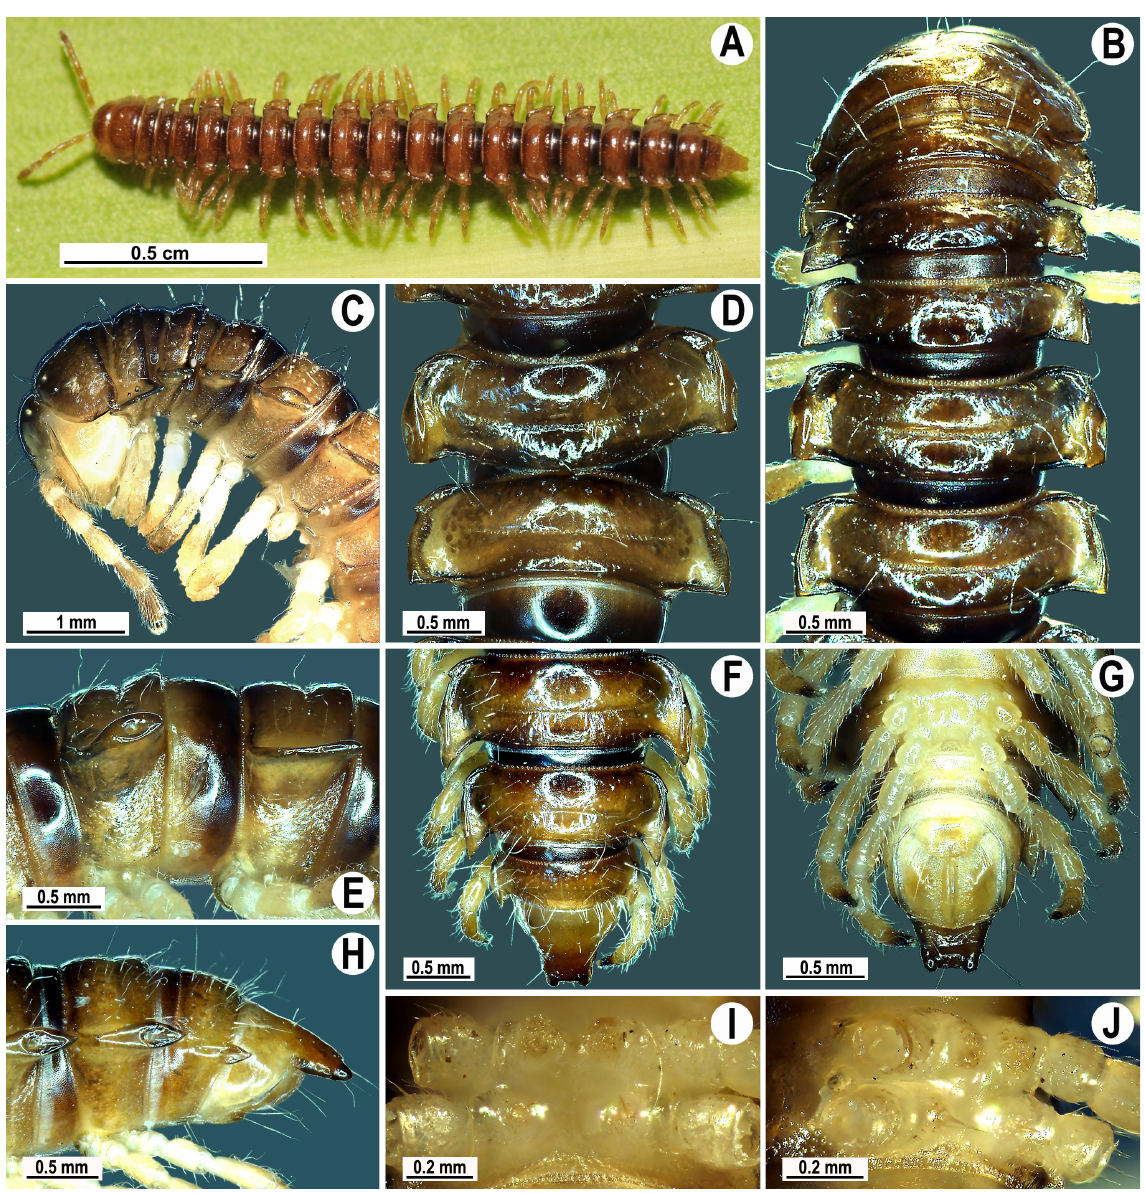
Fig. 10. Tylopus retusus sp. nov., holotype, ♂. A . habitus, live coloration. B–C . anterior part of body, dorsal and lateral views, respectively. D–E . Segments 10 and 11, dorsal and lateral views, respectively. F–H . Posterior part of body, dorsal, ventral and lateral views, respectively. I–J . Sternal cones between coxae 4, caudal and sublateral